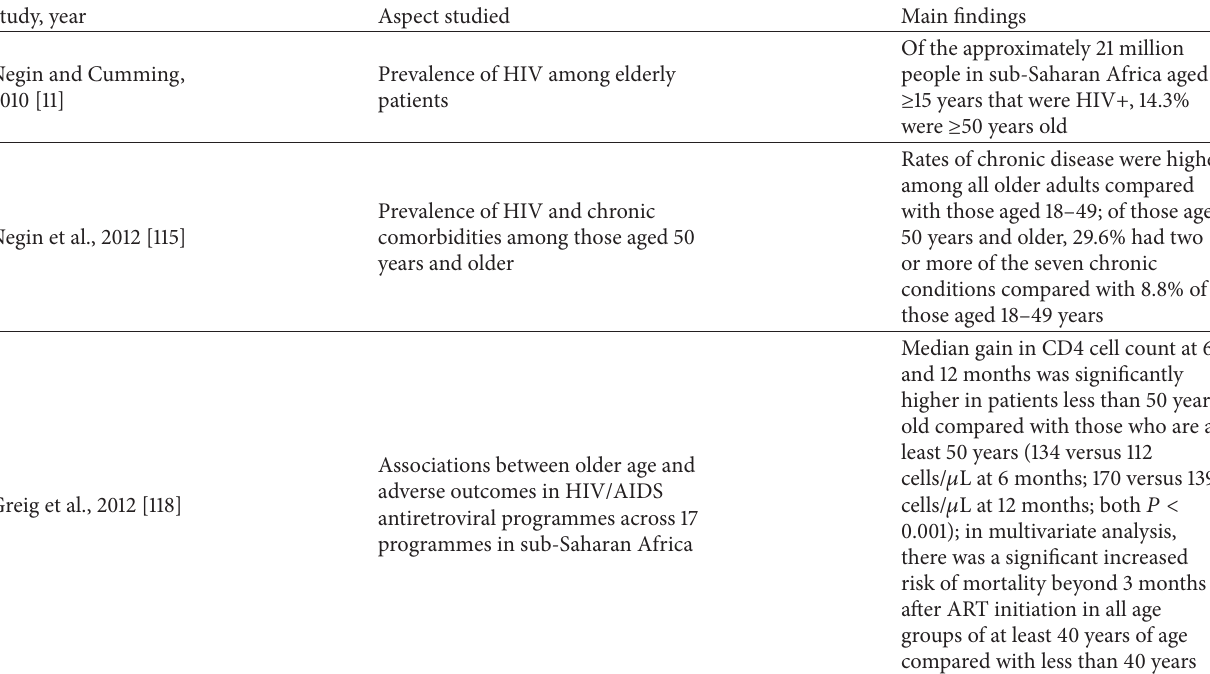
Table 2: Studies evaluating aging with HIV in sub-Saharan